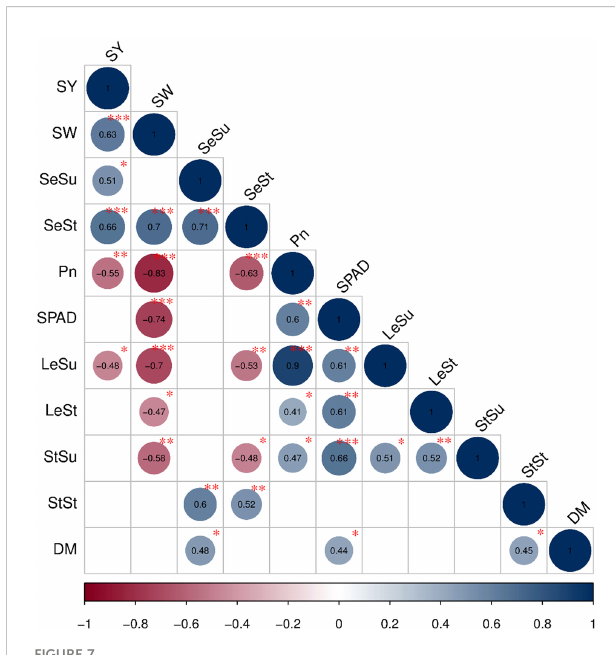
FIGURE 7 Pearson correlation analysis showing the relationships between growth factors and grain yield. The circle size shows the signi fi cant level and the circle color exhibited the positive or negative correlations. P-values less than 0.001, 0.01, 0.05 are indicated by the asterisks and dot symbols: ‘ *** ’ , ‘ ** ’ and ‘ * ’ .The abbreviations used in the fi gure are followed as: seed yield per plant (SY), seed weight (SW), seed sucrose content (SeSu), seed starch content (SeSt), photosynthetic rate (Pn), leaf sucrose content (LeSu), leaf starch content (LeSt), stem sucrose content (StSu), stem starch content (StSt), dry matter per plant